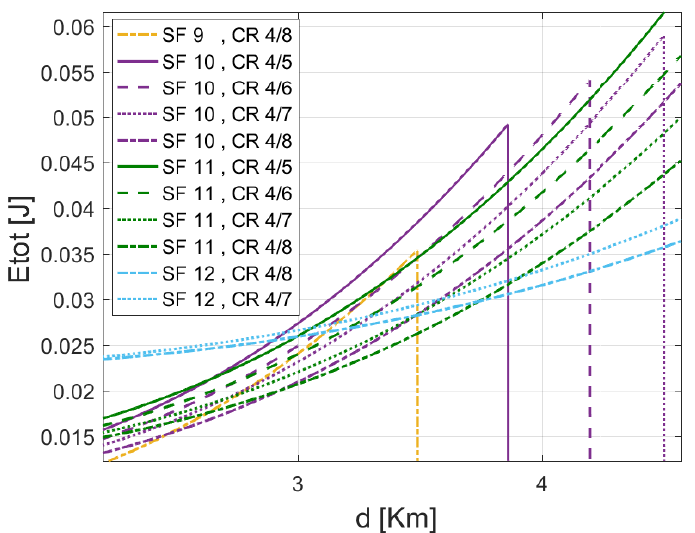
Figure 12. The total consumed energy by different possible transmission settings at the distance d = 3